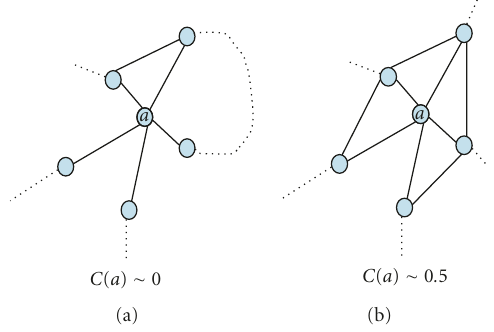
Figure 1: Illustration of clustering coe ffi cient of node a . Solid lines between nodes indicate direct links of weight 1, while dotted lines represent multiple link paths of weight > 1. The total number of possible triangles is 10. In Figure (a), the clustering coe ffi cient is 1/10, while in Figure (b) it is 4/10.